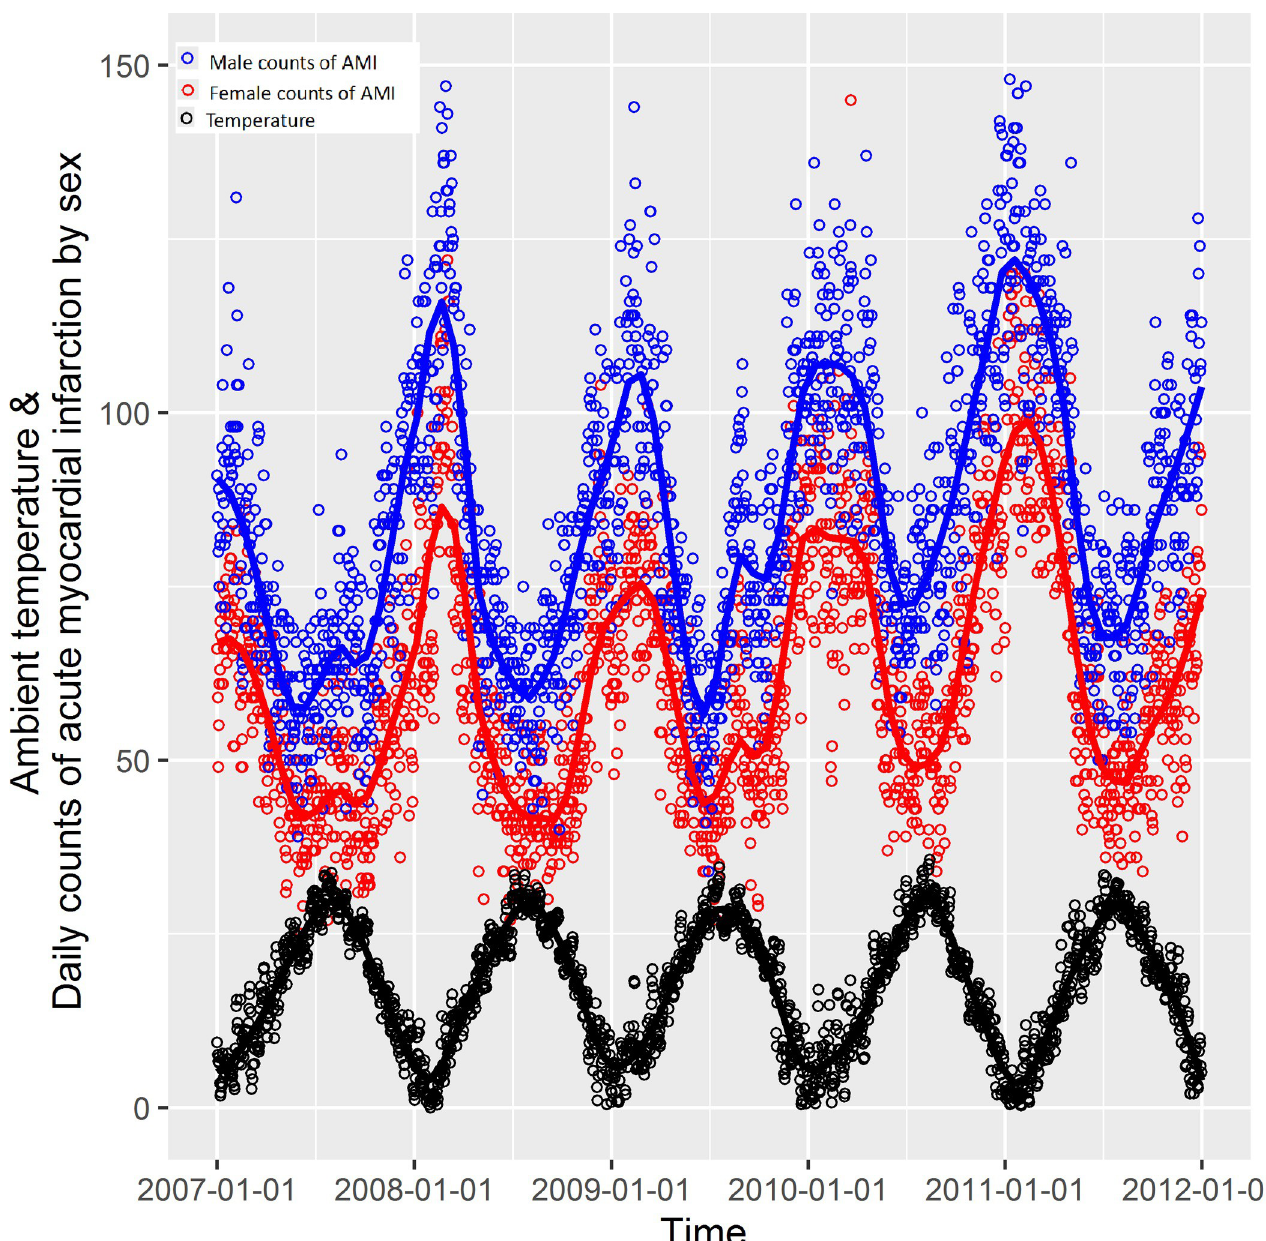
Fig 1. Time series of daily cases of Acute Myocardial Infarction (AMI) by sex and ambient temperature in Shanghai from 2007 to 2011.